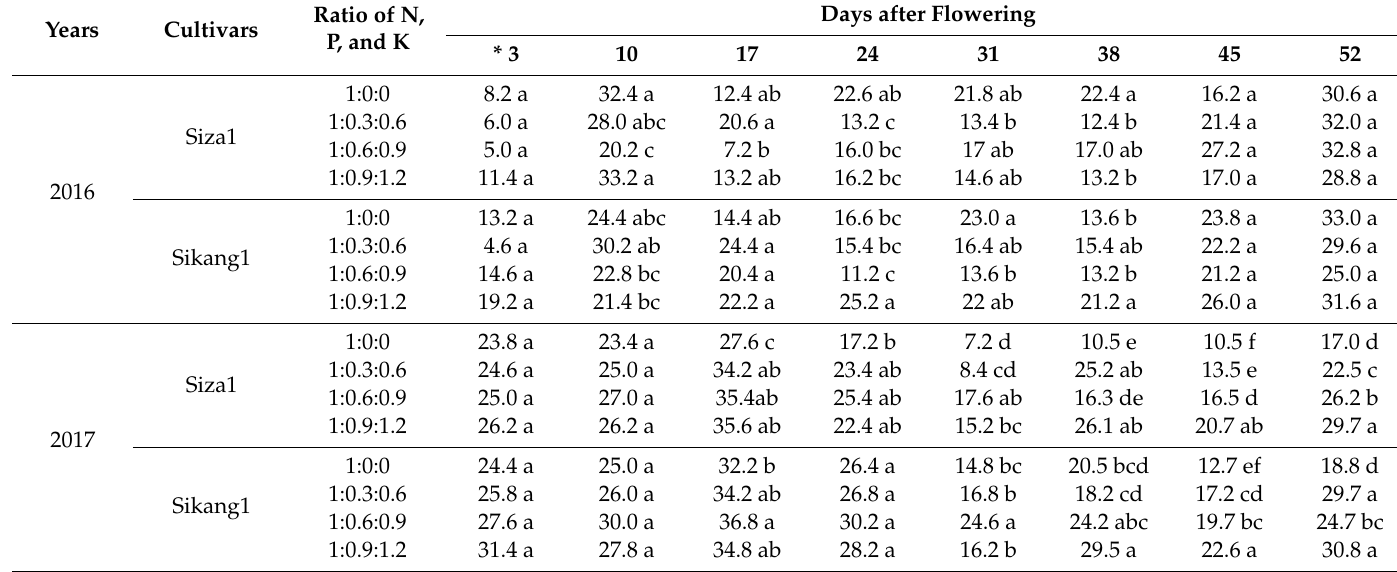
Table 5. E ff ects of the ratio of nitrogen, phosphorous, and potassium application on number of seeds boll − 1 of Siza 1 and Sikang 1 cotton plants in 2016 and 2017. Years Cultivars